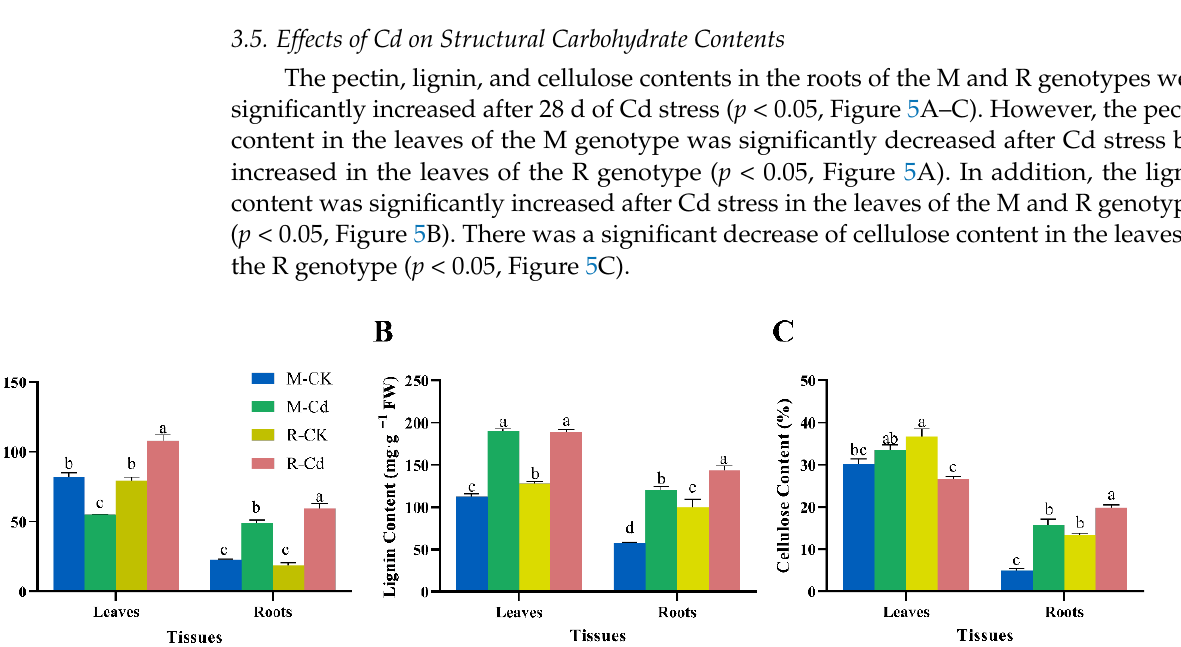
Figure 5. Effects of Cd stress on pectin ( A ), lignin ( B ), and cellulose ( C ) in the leaves and roots of the M and R genotypes. The significant differences between the M and R genotypes were based on one-way ANOVA. The different letters indicate that the difference is significant at a 0.05 level. Data were shown by “means ± SE”. CK and Cd represent treatments of 0 and 1000 μM Cd, respectively.